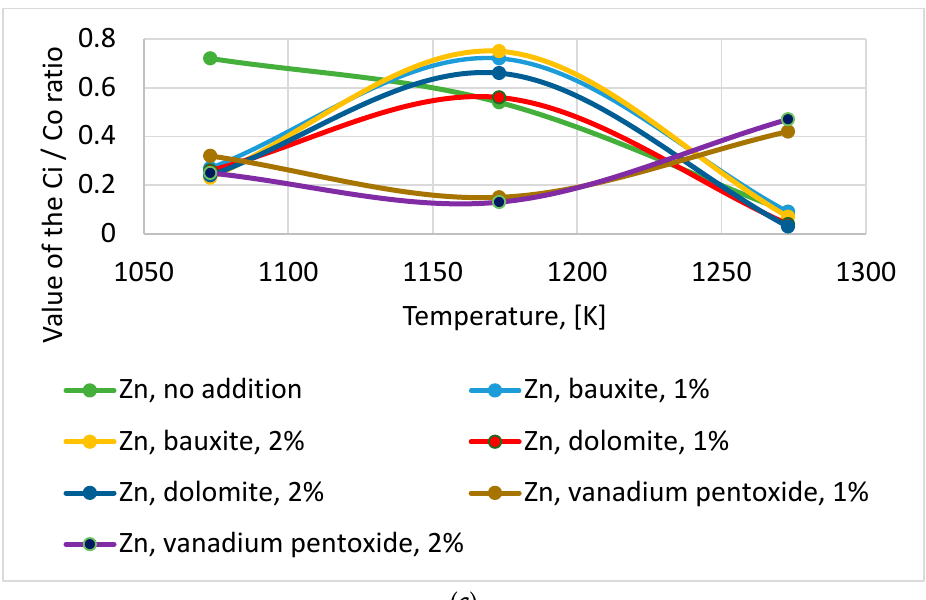
Figure 8. Dependence of the Ci/C o value on the combustion temperature of fuel from SRF waste: ( a ) cadmium, ( b ) copper, ( c )